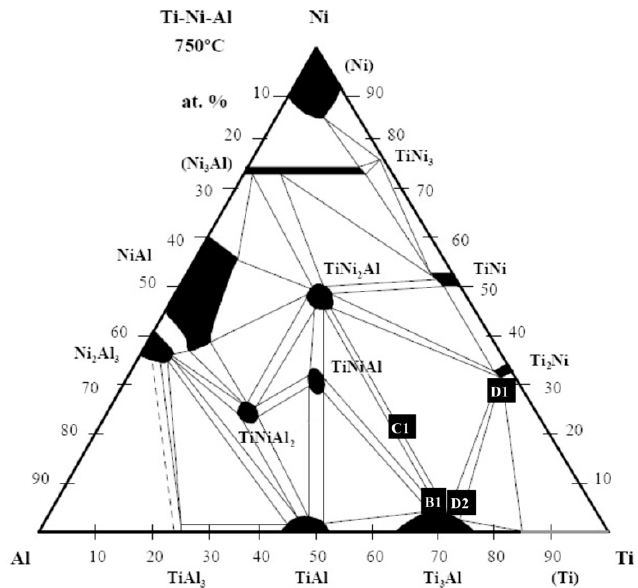
Figure 7. Isothermal section at 750 °C of the Al-Ni-Ti [20] ternary phase diagram, where the EDS chemical compositions of B1, C1, D1, and D2 zones are plotted.